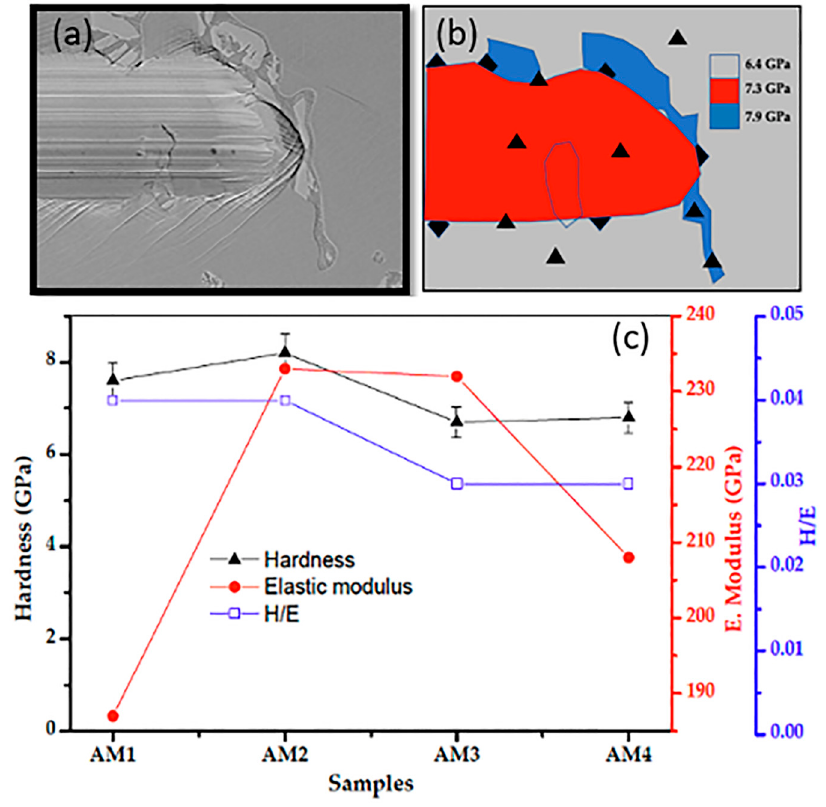
Figure 14. Results obtained using the Berkovich indentation technique. ( a ) Image of the end of the scratch performed on the surface of the sample. ( b ) Schematic interpretation of the indentation test in the sample ( c ) Hardness Hardness test results, Young’s modulus, and H/E ratio.